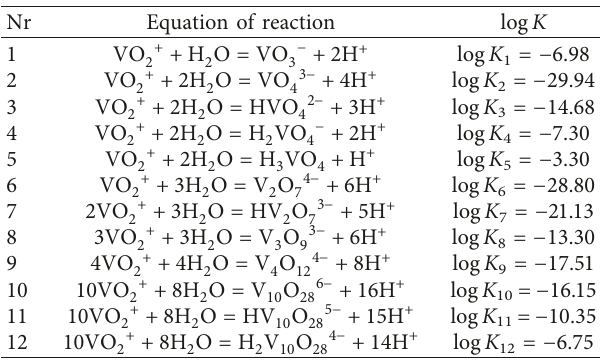
Table 2: Complex chemical transformations of the vanadyl ion in the solution at 295 ± 1K [4,